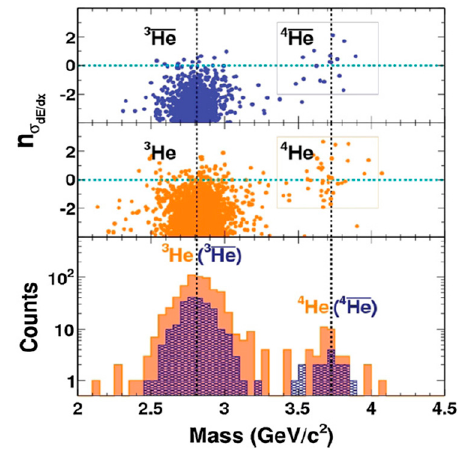
Figure 5. The top two panels show the dE/dx (in units of multiples of σ dE/dx , n σ ) of 3 He/ 4 He and 3 He/ 4 He as a function of mass. The bottom panel shows a projection of entries in the upper two panels onto the mass axis. Reproduced with permission from Star Collaboration, Nature; published by Springer Nature, 2011 [60].